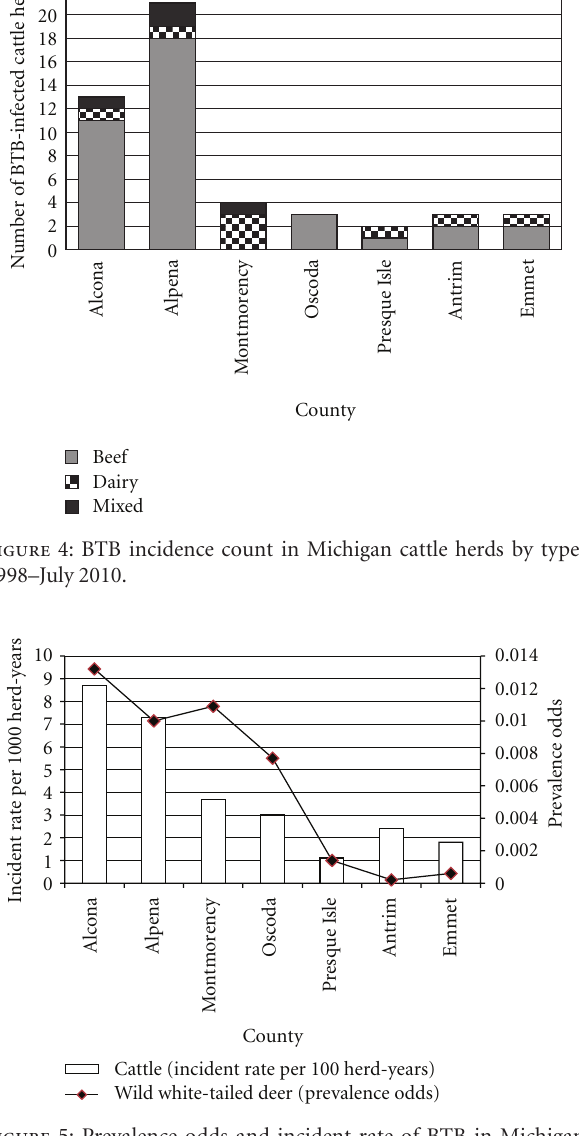
program. The latest reinfection was not considered a separate infection because the herd was still quarantined at the time. Again, only BTB test negative animals were allowed onto these